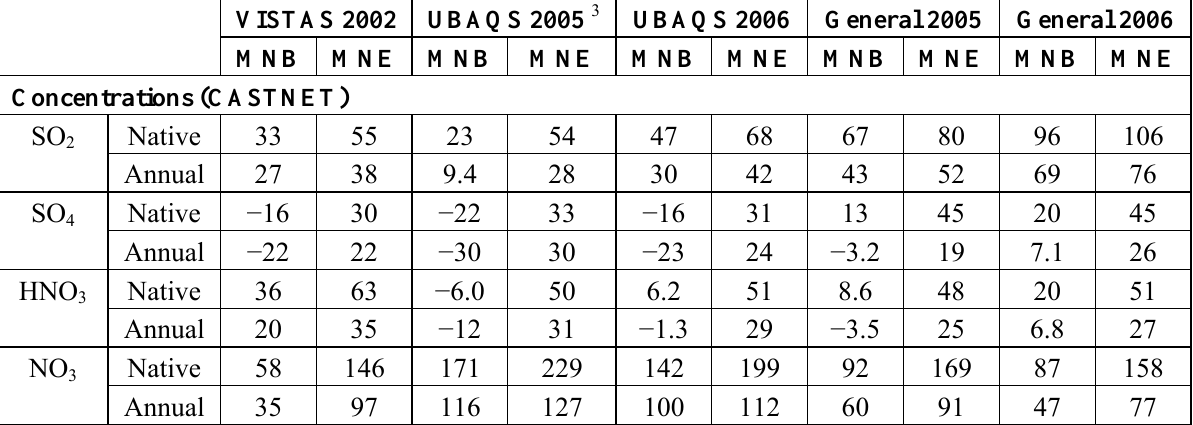
Table 2. Model performance statistics 1 for various sulfur or nitrogen compounds using annualized quantities and those with native sampling frequency 2